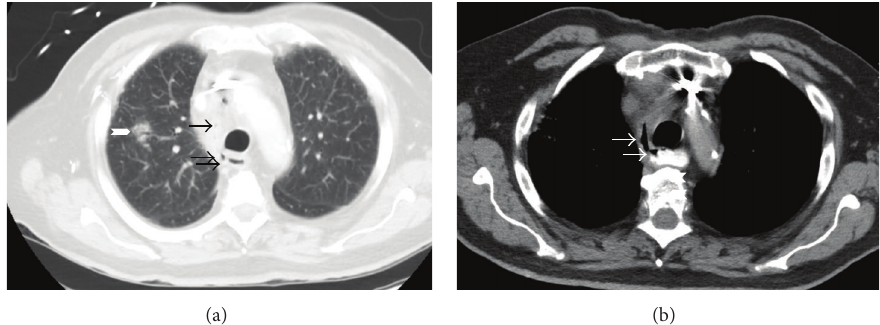
Figure 1: (a) Sagittal CT scan demonstrating fistulous tract containing air bubbles (arrows) and surrounding inflammation extending from the right lateral esophageal wall and right upper lobe pulmonary opacification (chevron). (b) CT esophagram demonstrating fistulous tract (arrows) extending from the right anterolateral esophagus to the mediastinum.